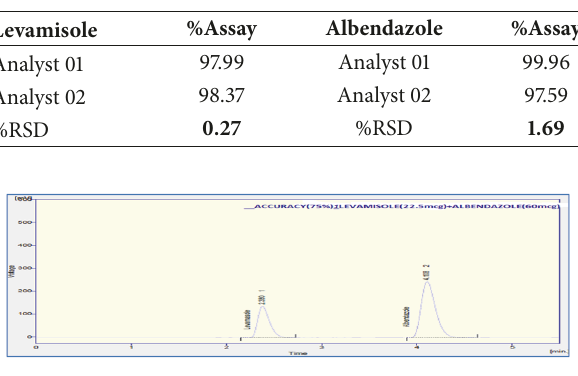
Figure 9: Chromatogram of 75% recovery.